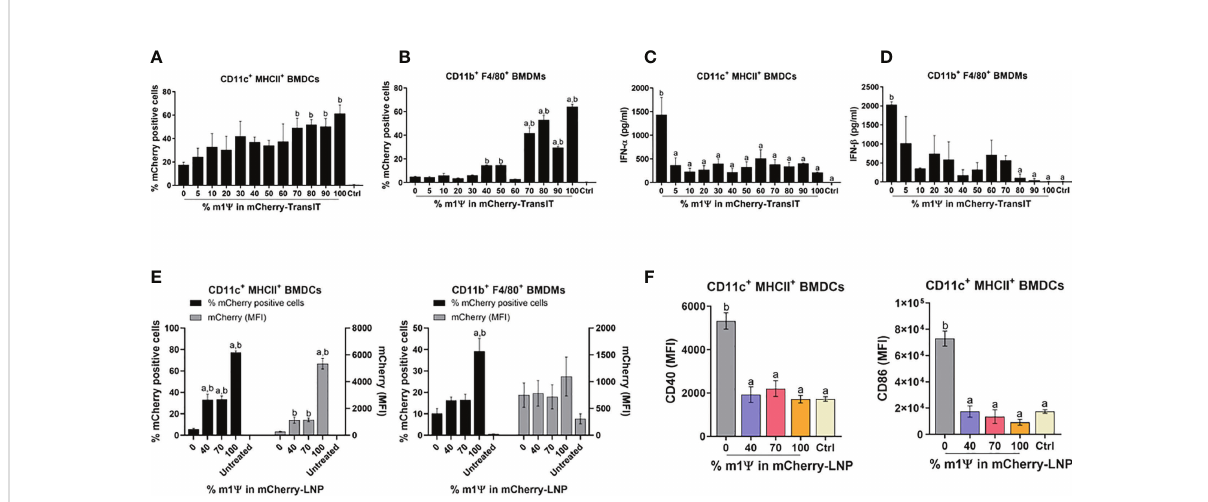
FIGURE 1 TransIT and LNP ef fi ciently delivered mRNA to murine BMDCs and BMDMs in vitro . (A – D) mCherry-encoding mRNA modi fi ed with different % of m1 Y (0.1 µg) were transfected into BMDCs and BMDMs using TransIT reagent. The frequencies of mCherry positive (A) BMDCs and (B) BMDMs were determined by fl ow cytometry at 48 hr after transfection. (C) The levels of IFN- a and (D) IFN- b released upon mRNA transfection from BMDCs and BMDMs, respectively were examined by ELISA. (E) mCherry-encoding mRNA modi fi ed with different % of m1 Y (0.1 µg) were delivered into BMDCs and BMDMs using LNP. The frequencies of mCherry positive BMDCs (left) and BMDMs (right) and MFI of mCherry delivered by LNP were determined by fl ow cytometry. (F) MFI of CD40 (left) and CD86 (right) on BMDCs upon mRNA-LNP transfection was shown. The control were untranfected cells. The results are presented as the mean ± SEM of at least duplicate samples and experiments were performed at least two times. Statistical signi fi cance by one-way ANOVA with Bonferroni multiple comparisons test were indicated when p < 0.05 compared to the unmodi fi ed target antigen: a, or control (PBS):